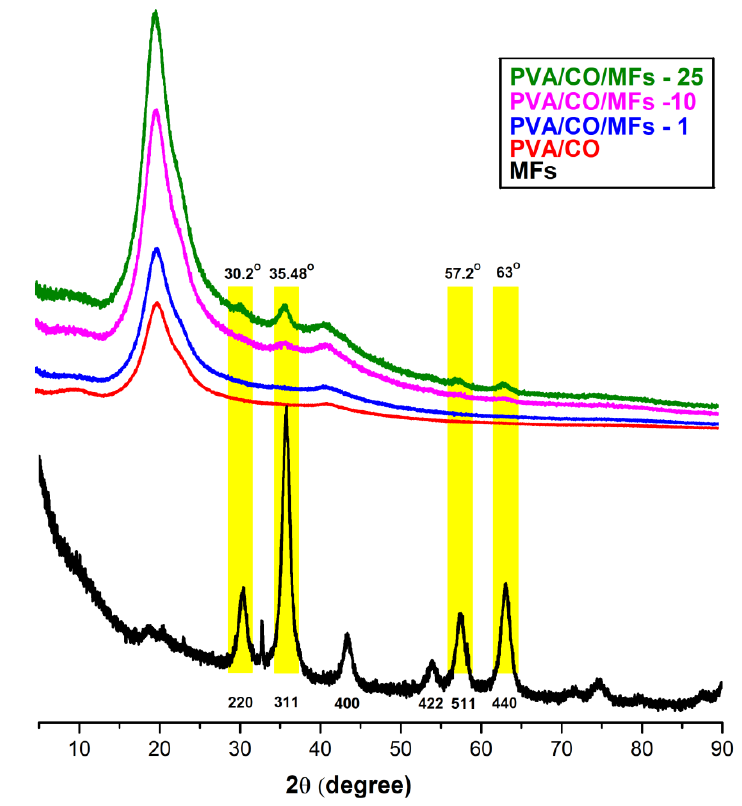
Figure 2. The XRD spectra of MFs, PVA/CO, and the magnetic hydrogels PVA/CO/MFs-1, PVA/CO/MFs-10, and PVA/CO/MFs-25.